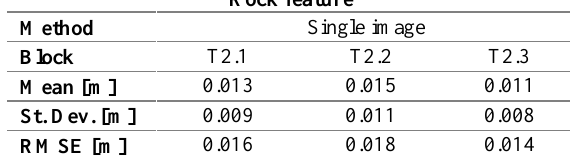
photogrammetric models generated with the single image acquisition method on a detail of a unique rock feature for T2.1, T2.2 and T2.3